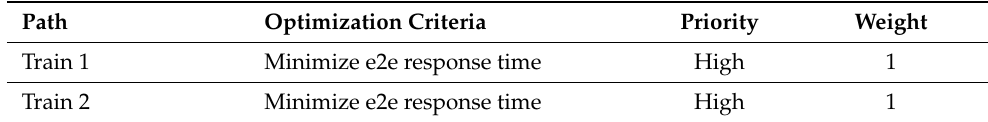
Table 7. Smoke monitoring application optimization